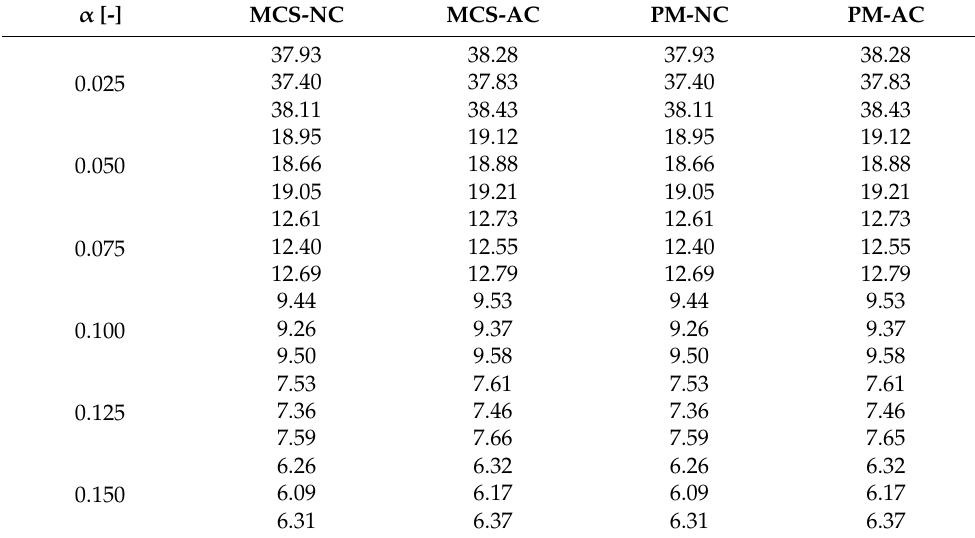
Table 3. Reliability indices β in the SLS via numerical and analytical methods based on the Monte Carlo simulation method and the stochastic perturbation technique for the triangular, uniform and Gaussian PDFs. α [-] MCS-NC MCS-AC PM-NC